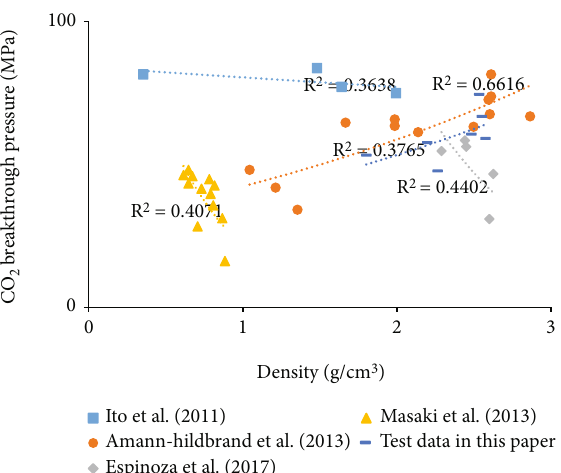
Figure 7: Relationship between density and breakthrough pressure of CO . 2